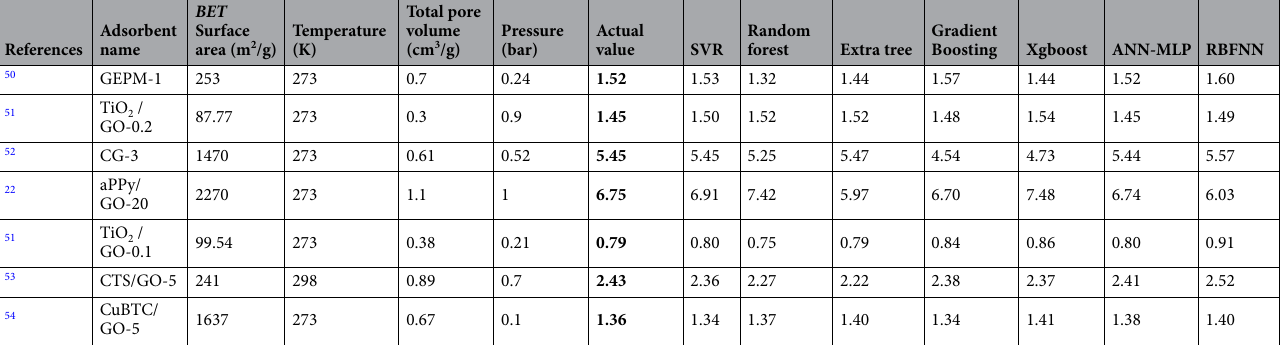
Table 3. Calculation of adsorption paraemters by models by fitting the experimental data. Significant values are on